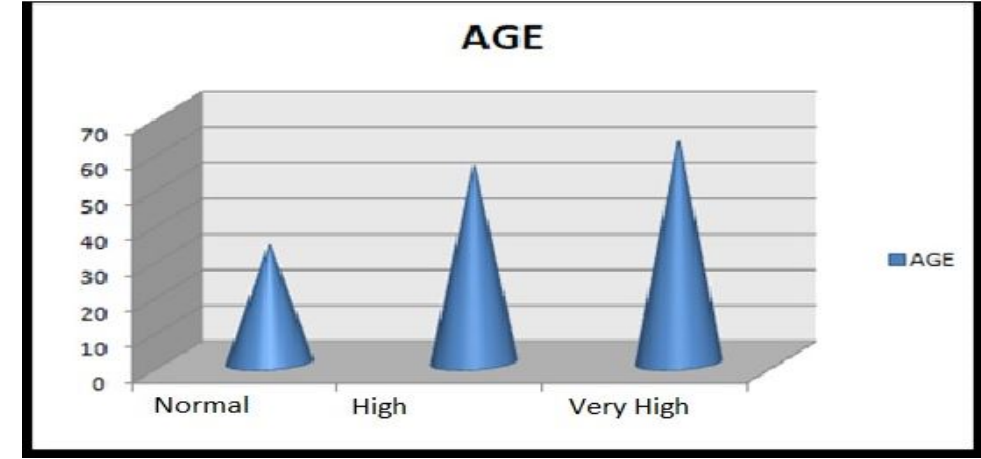
Figure 7. Levels of the patients’ age.